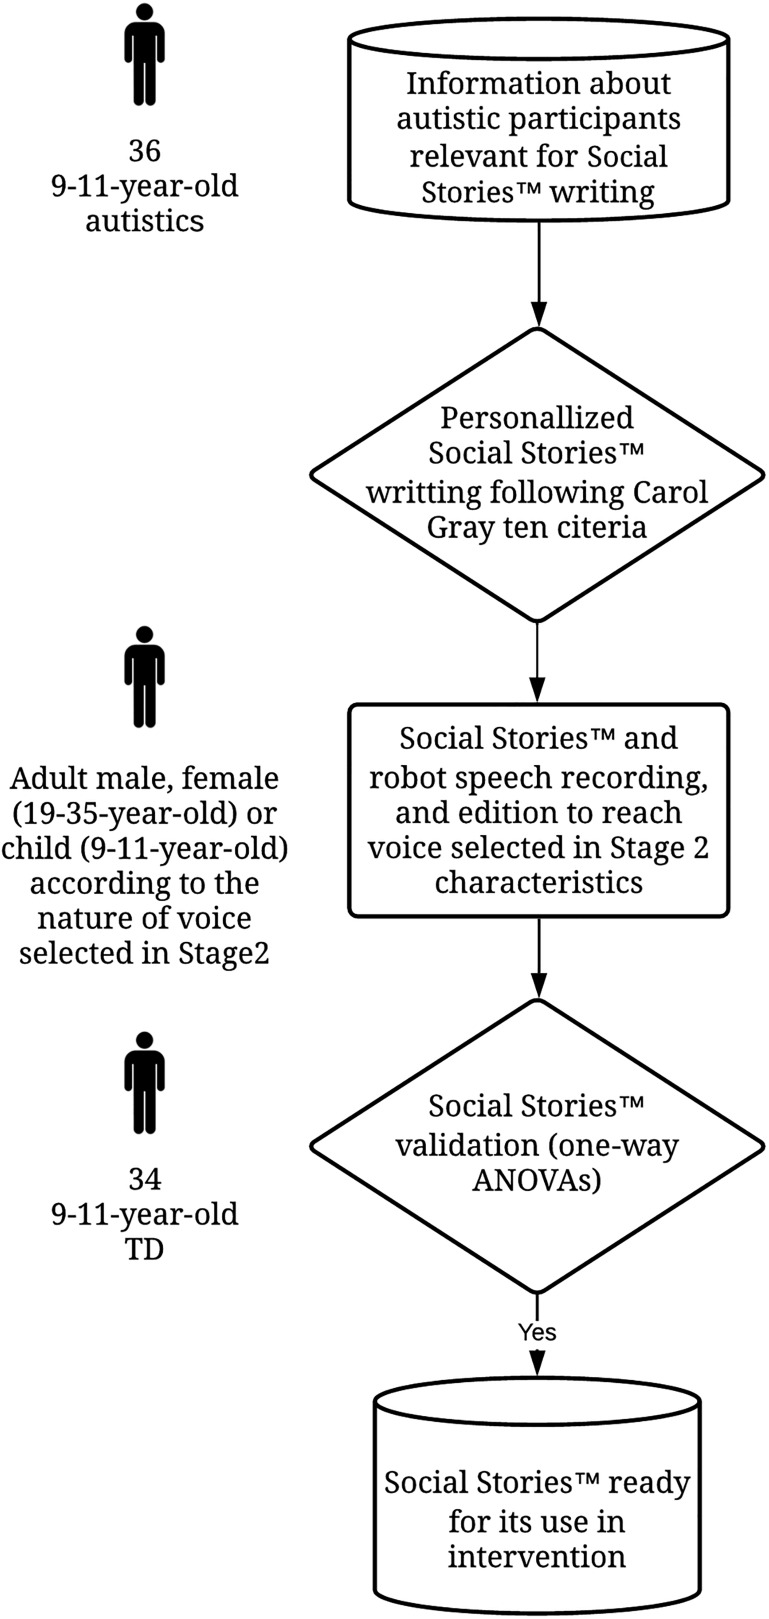
Process for Social StoriesTM elaboration before their use in intervention. TD, Typically developed.